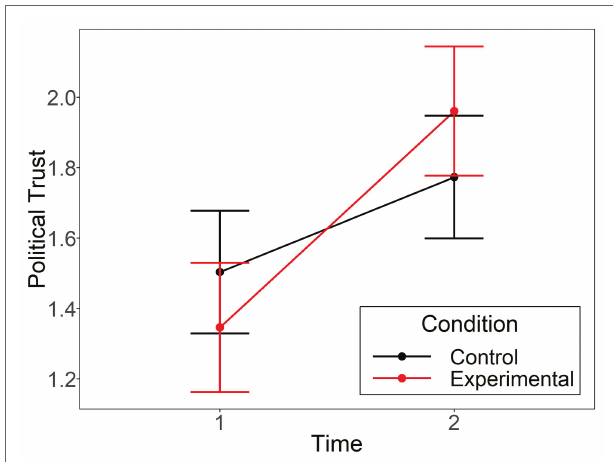
FIGURE 2 | The political trust means in Study 2 at time 1 and 2 are displayed separately for the control and experimental group. Error bars represent 95% confidence